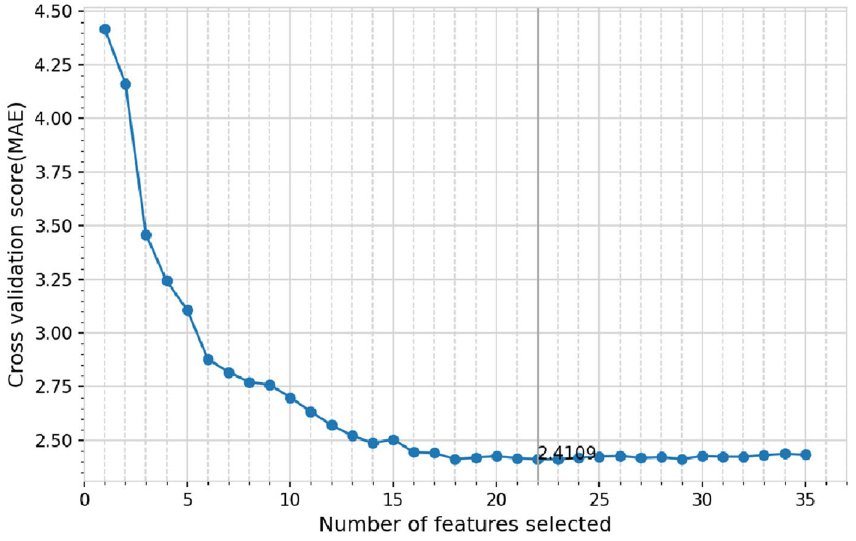
Figure 5. XGBoost-RFE feature selection results: Cross-validation MAE under optimal hyperparameter combination.